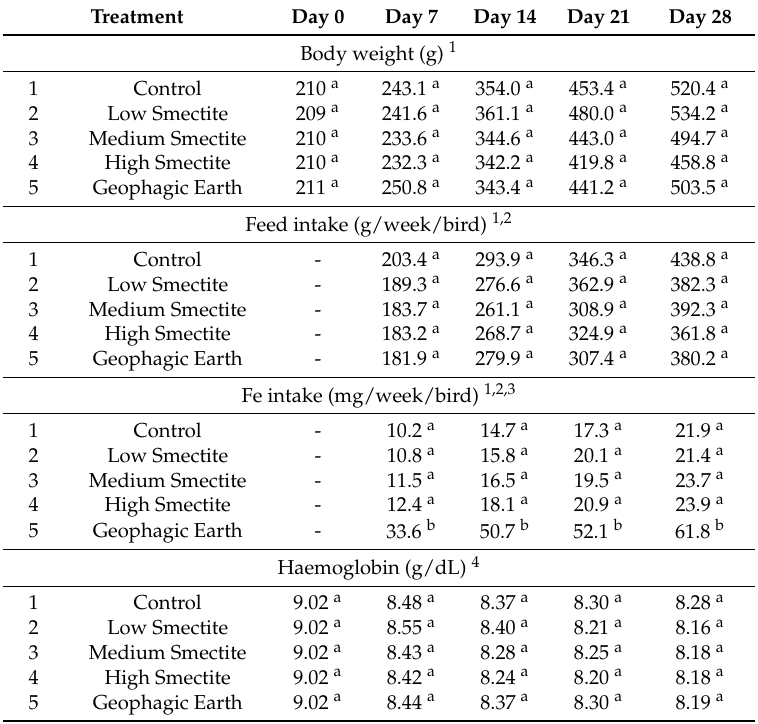
Table 3. Body weights, cumulative weekly feed intake, Fe intake, and Hb from day 0 to day 28 of experiment, by treatment